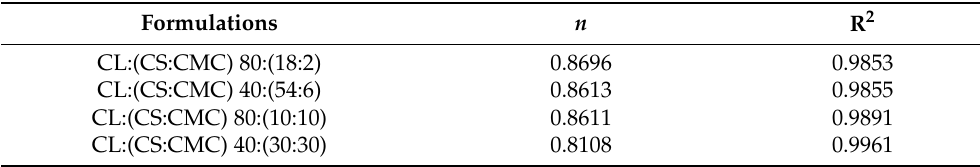
Table 1. Korsmeyer-Peppas kinetic model applied for clarithromycin release from PEC